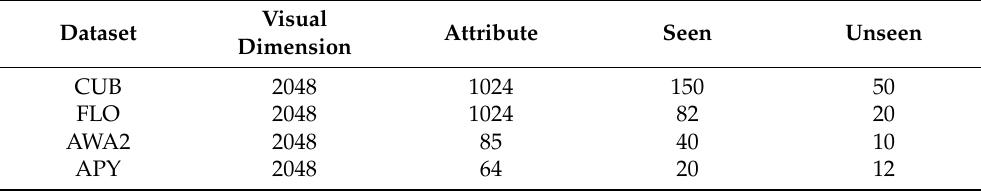
Table 1. Statistics of the datasets used in our experiments, including the dimensions of visual features (visual dimension), the dimensions of semantic vectors per class (attribute), seen class size (seen), and unseen class size